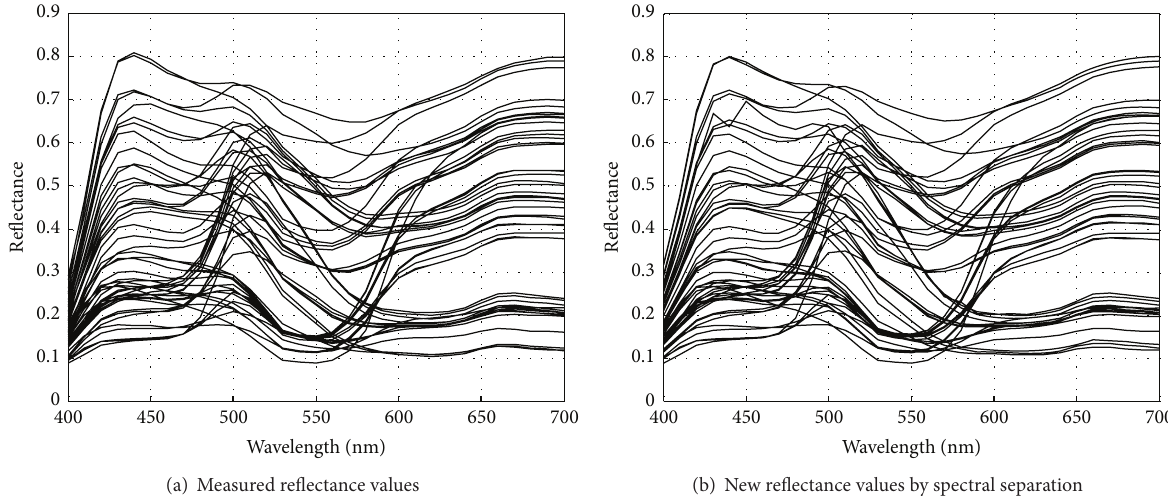
Figure 6: Comparison of the original and newly separated spectral values of the 50 testing